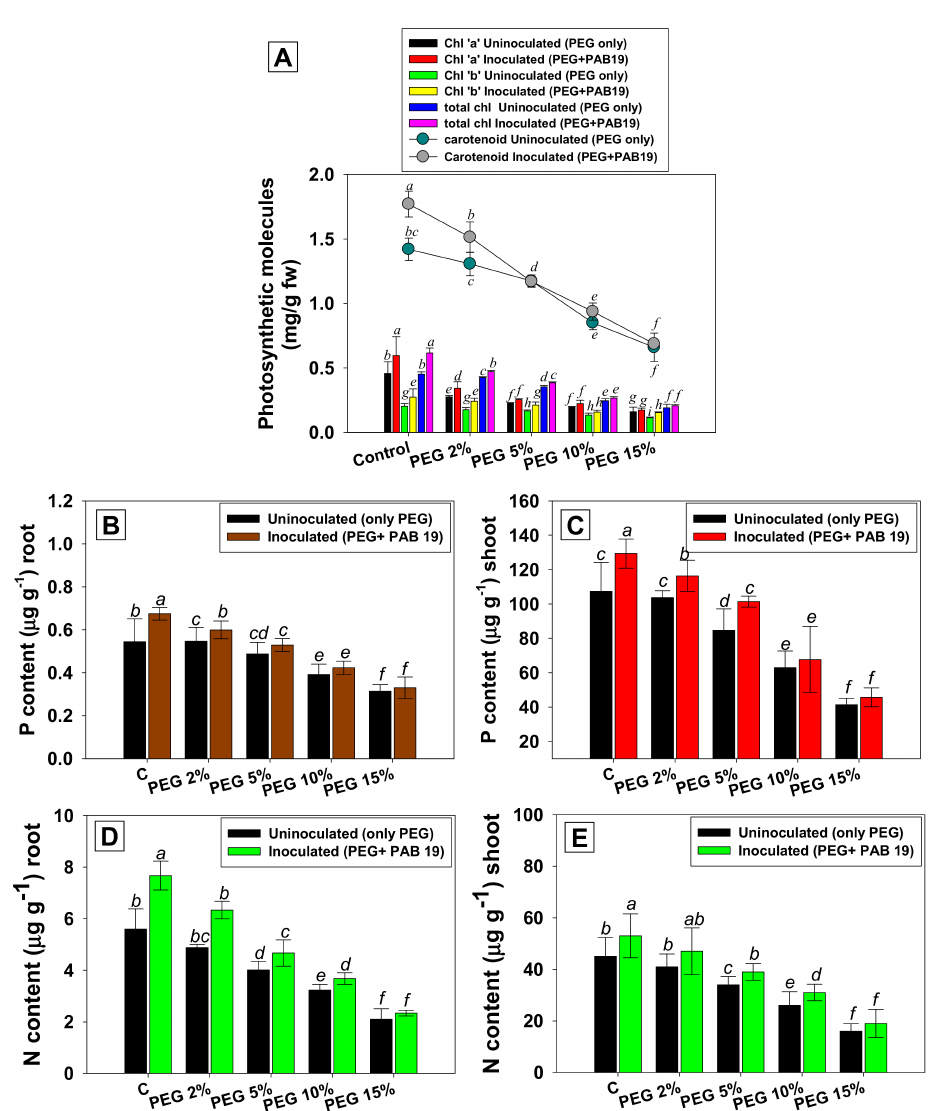
Figure 5. Impacts of the bio-inoculation of Enterobacter sp./ L. adecarboxylata PAB19 on leaf pigments ( A ), shoot P ( B ), root P ( C ), shoot N ( D ), and root N ( E ) of V. radiata (L.) cultivated under different levels of drought stress (2%, 5%, 10% and 15% PEG-6000) under greenhouse conditions. Mean values followed by different letters are significantly different ( p ≤ 0.05) as determined by the DMRT test. Bar and scatter plots represent means ± SDs. Bar and scatter plots represent means ±